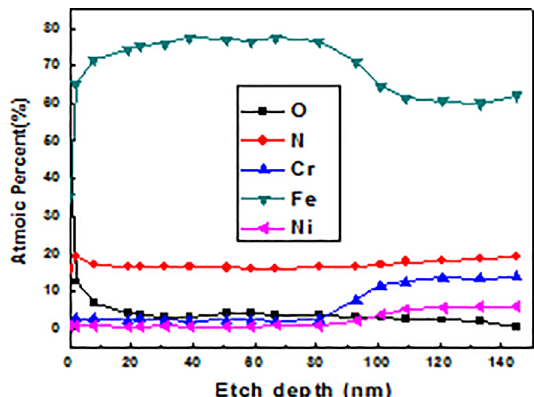
Figure 6 . The variation of atomic concentrations of N, O, Fe, Cr and Ni elements with depth of the 440°C oxy-nitrided